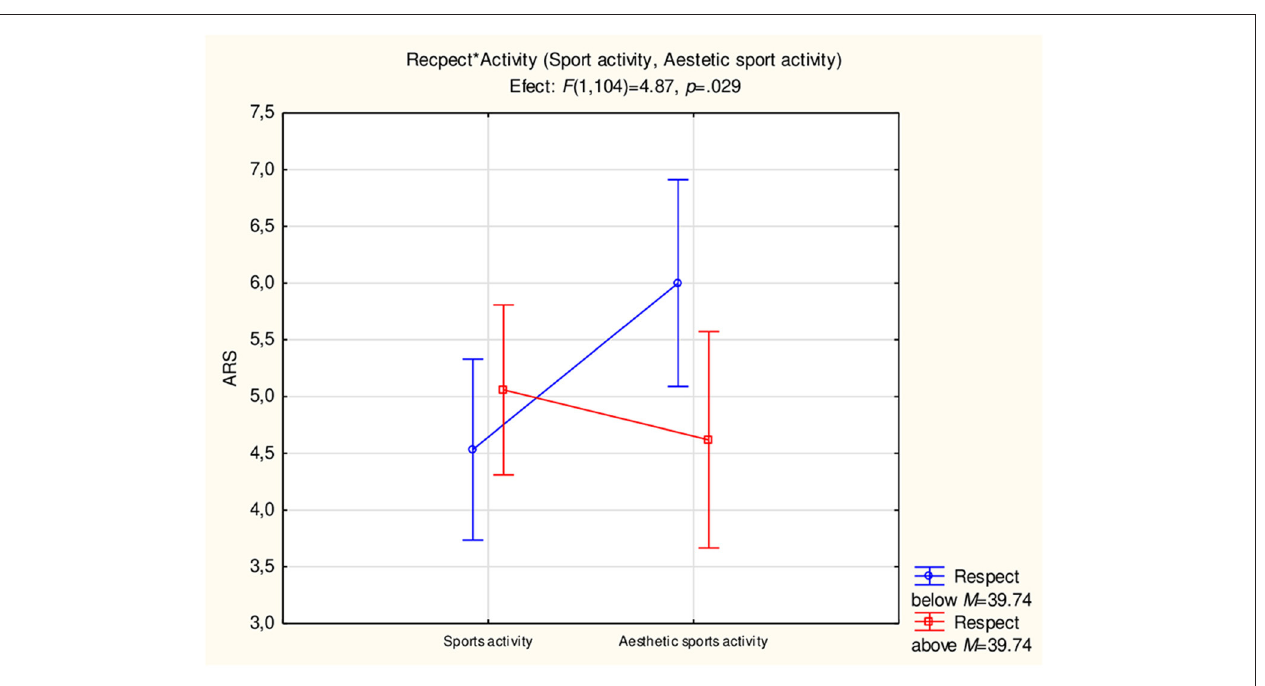
FIGURE 3 | Moderating role of the factor Respect (FS) for the severity of ARS depending on sports